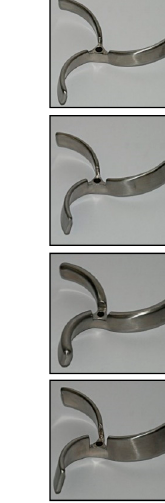
Figure 9. Optimized geometry configuration of agitator with curved blades for enameled equipment ( R / d = 1/3; h / d = 0.1–0.2; max. s / d = 0.03–0.07).